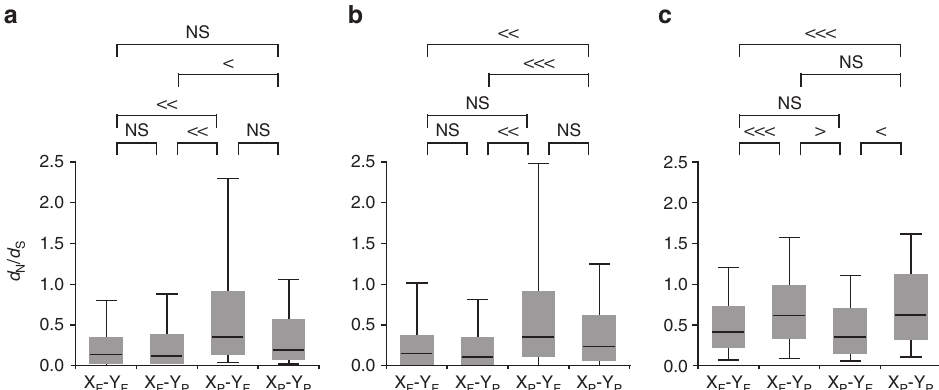
Figure 3 | Ratios of non-synonymous to synonymous nucleotide distance. The 1,282 orthologues that are likely to be functional in D. obscura and not to have experienced any inter-chromosomal translocation after the species split from D. obscura were analysed. The lines in the boxes represent medians, 50% of values are included in the boxes, and 80% of values are included within the bars. X F -Y F , a group of genes whose orthologues are functional on both neo-X and neo-Y; X F -Y P , a group of genes whose orthologues are functional on the neo-X and non-functional on the neo-Y; X P -Y F , a group of genes whose orthologues are non-functional on the neo-X and functional on the neo-Y; X P -Y P , a group of genes whose orthologues are non-functional on both neo-X and neo-Y. Statistical significance was calculated based on a Monte Carlo simulation with 1,000 bootstrap replicates: 444 or ooo , P o 0.001; 44 or oo , P o 0.01; 4 or o , P o 0.05; NS, P Z 0.05. Note that the Mann-Whitney U test also showed the same trend. Ratios of non-synonymous to synonymous nucleotide distance ( d N / d S ratios) on ( a ) the ancestral branch before separating the neo-X and neo-Y, ( b ) the neo-X branch, and ( c ) the neo-Y